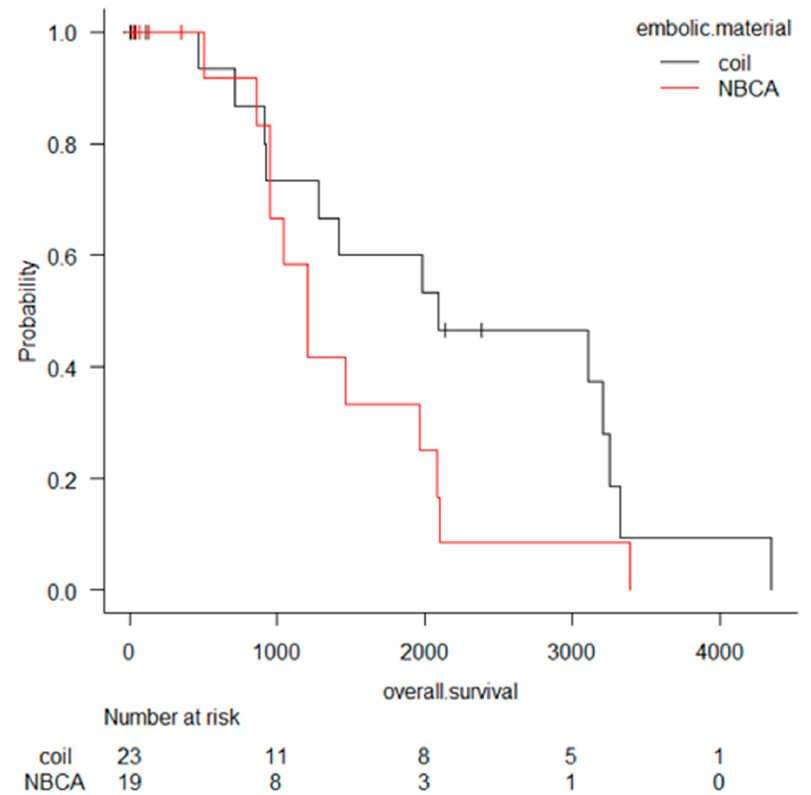
Figure 1. Overall survival after transcatheter arterial embolization (TAE) for hemorrhage due to pancreatitis or pancreatectomy. Patients who underwent TAE with coils tend to survive longer than those who underwent TAE with NBCA, however there is no significant difference. those who underwent TAE with NBCA, however there is no significant